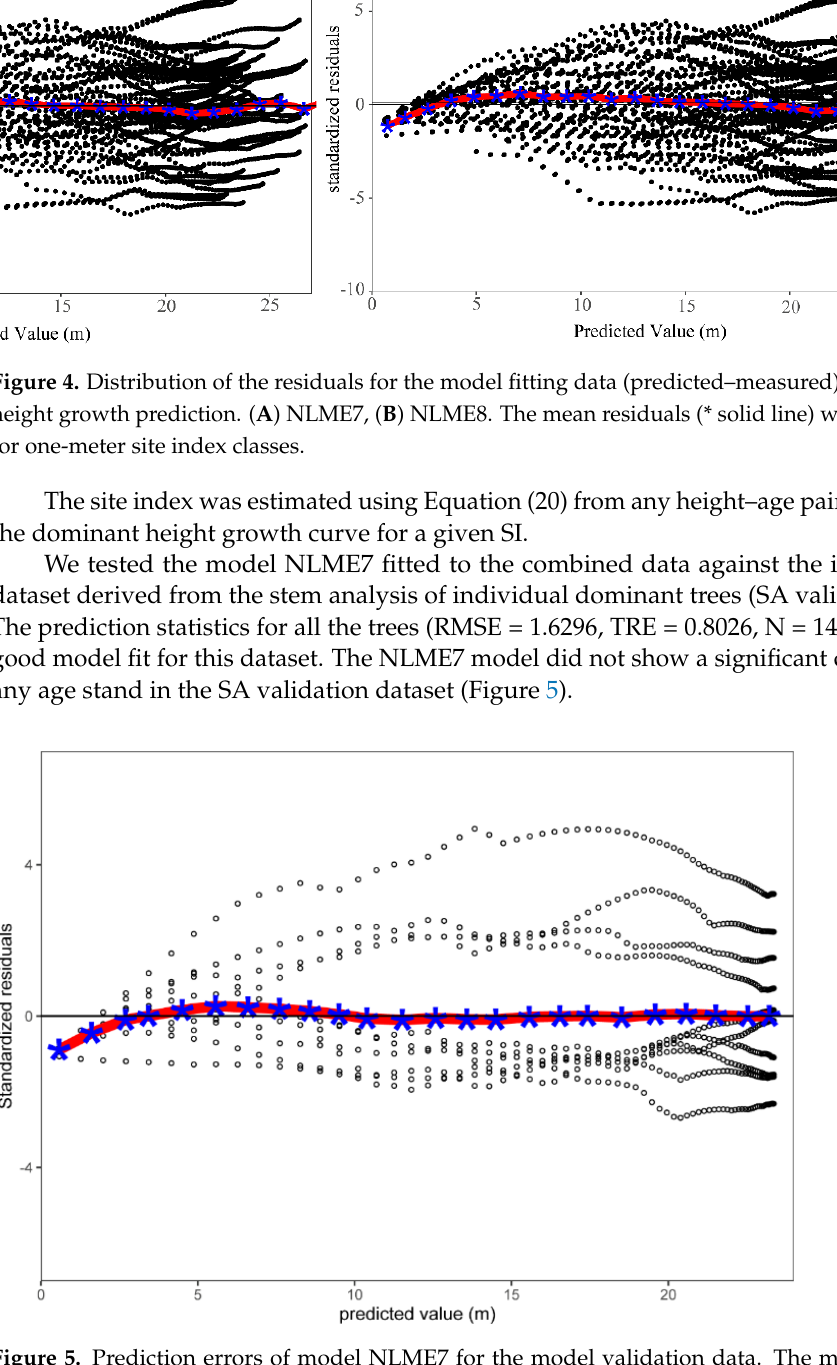
Figure 6. The new height growth model (Equation (19)) for curves corresponding to a site index with a 2 m interval of 14 m to 26 m (dominant height at age 45).